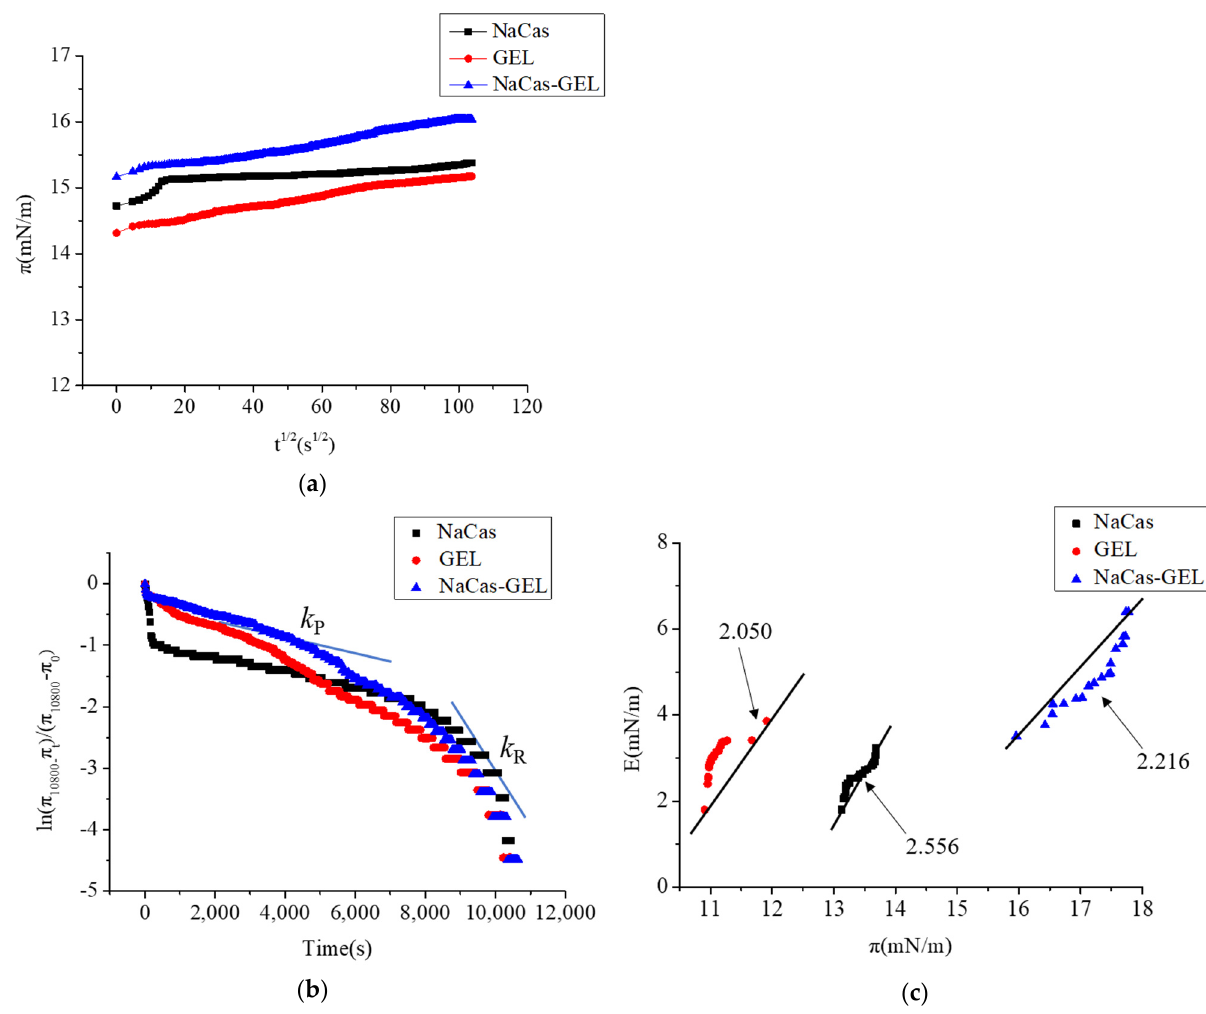
Figure 6. Interface adsorption characteristic at the oil–water interface: ( a ) Interfacial pressure ( π ) at the oil − water interface as a function of time (t1/2); ( b ) Molecular permeation and structural rearrangement at the oil–water interface; ( c ) Surface − dilatational modulus (E) as a function of surface pressure ( π ).